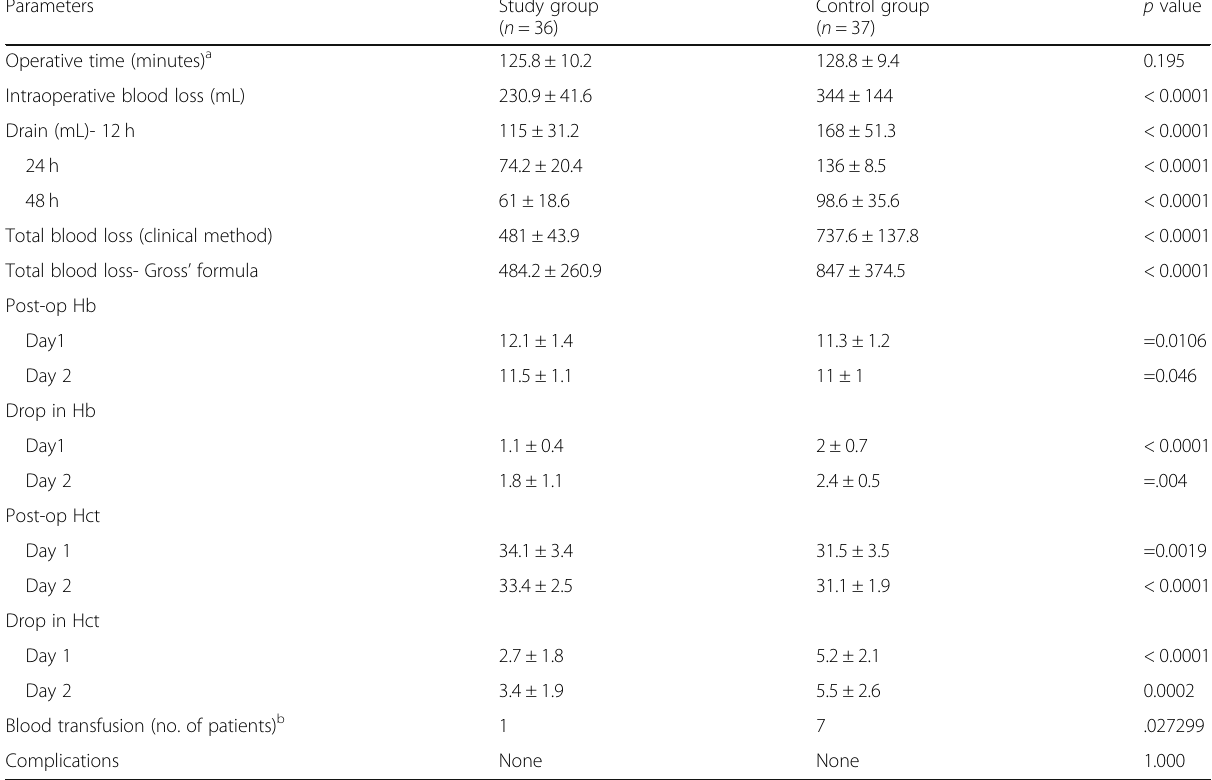
Table 2 Comparison of intra- and postoperative characteristics between the two groups